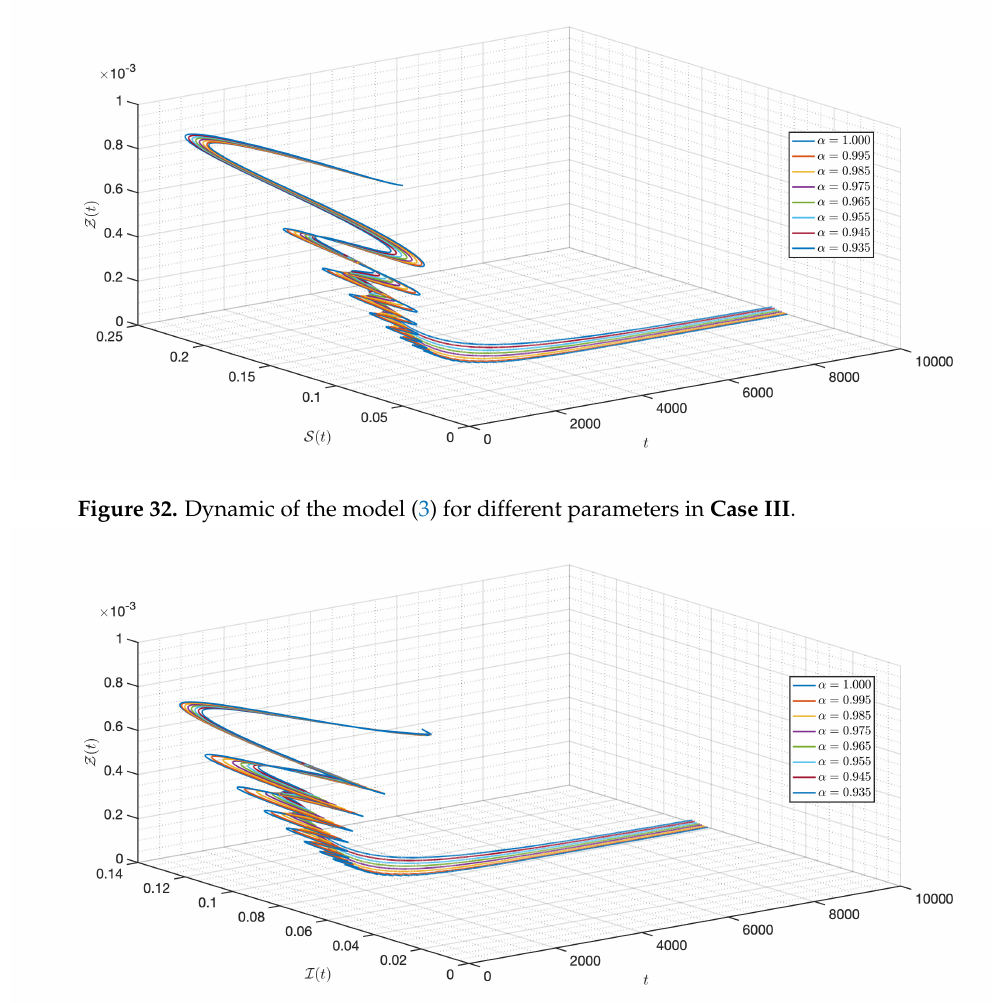
Figure 33. Dynamic of the model (3) for different parameters in Case III